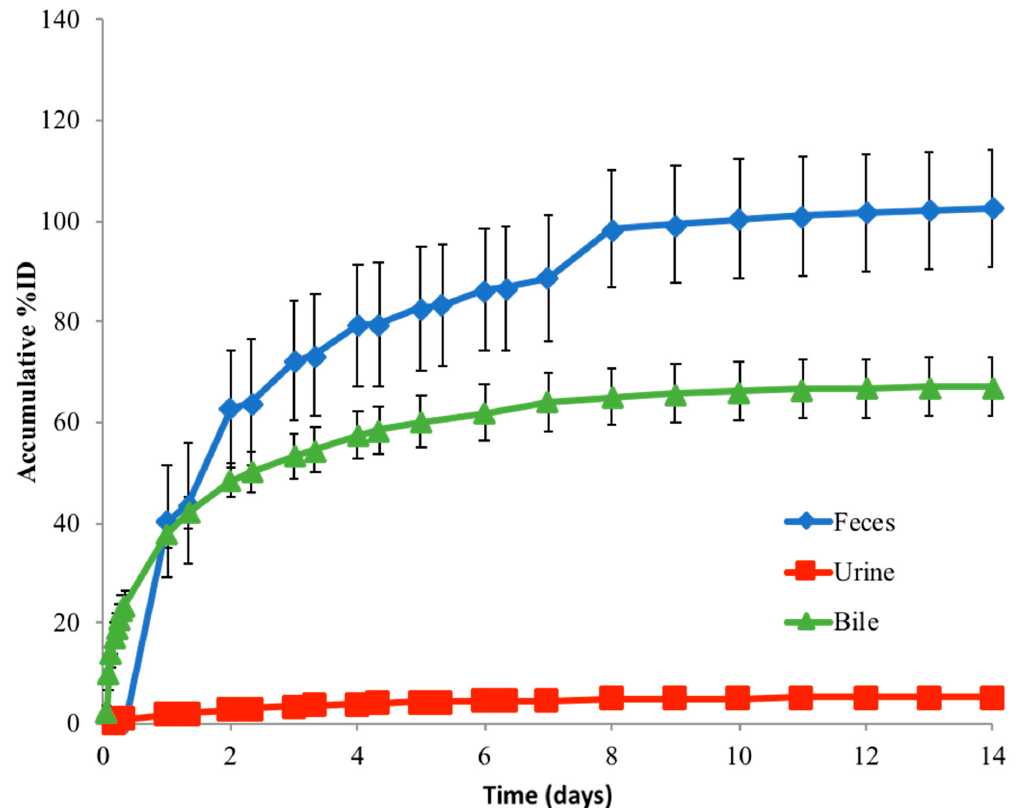
Figure 7. The route of elimination of [ 3 H]-MMAE-polatuzumab vedotin in rats following a single IV administration. The total 3 H radioactivity in the feces and urine samples collected through the study. Bile samples were collected in a separate set of bile-duct-cannulated rats. The acetonitrile (ACN) precipitation of urine and feces samples showed that the majority (>80%) of radioactivity was in the ACN-soluble fraction, suggesting that [ 3 H]-MMAE-polatuzumab vedotin was eliminated mainly as [ 3 H]-MMAE or [ 3 H]-containing small molecule catabolites. Similarly, the acetonitrile precipitation of bile samples showed >95% of the radioactivity in the soluble fraction. The data are represented as the mean ± SD. For the urine and feces data, n = 6 per time point up to 7 days (including at day 7), n = 3 per time point from beyond 7 days to the end of the study. n = 6 per time point for the bile samples.